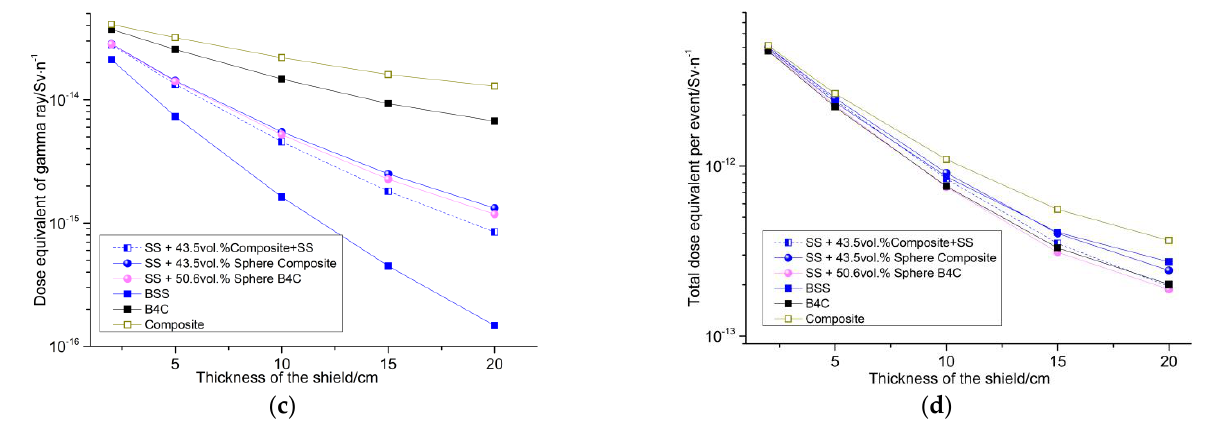
Figure 3. The shielding performance of six groups of materials. ( a ) The dose equivalent of the neutron. ( b ) The dose equivalent of the second gamma rays. ( c ) The dose equivalent of the primary gamma rays. ( d ) The dose equivalent of the total.